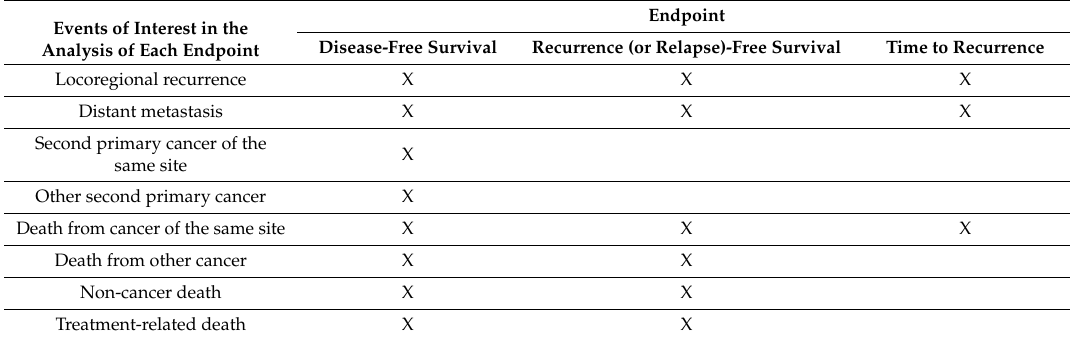
Table 3. Definition of selected time-to-event endpoints for adjuvant therapy